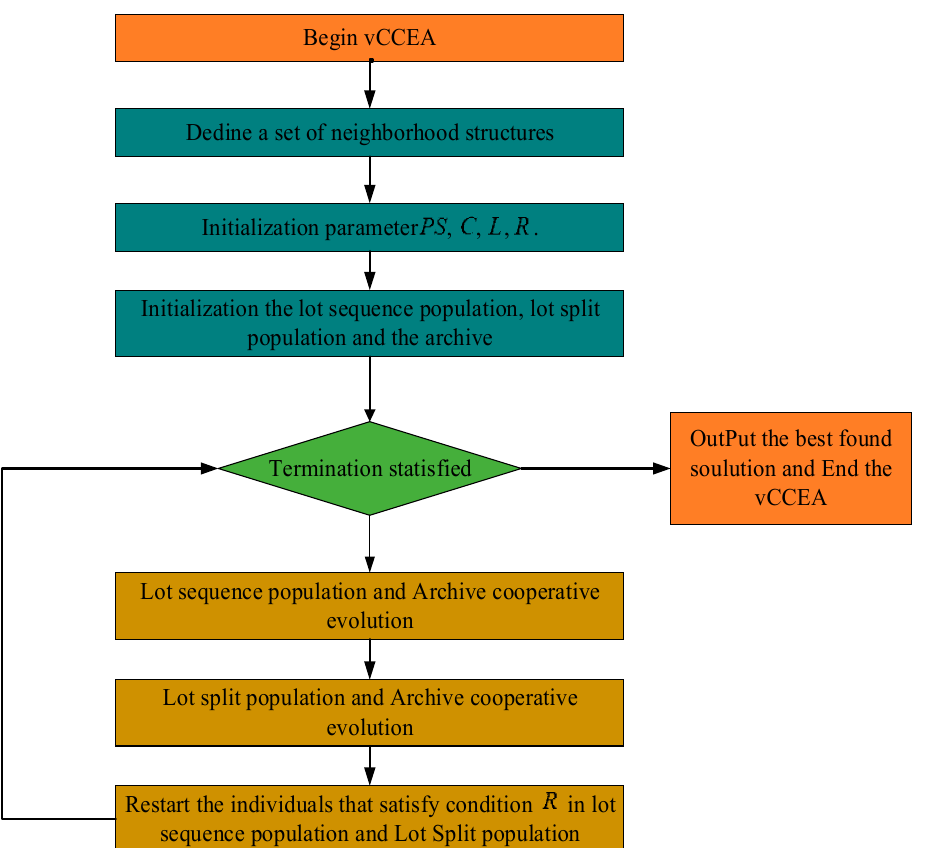
Figure 1. The framework of vCCEA.